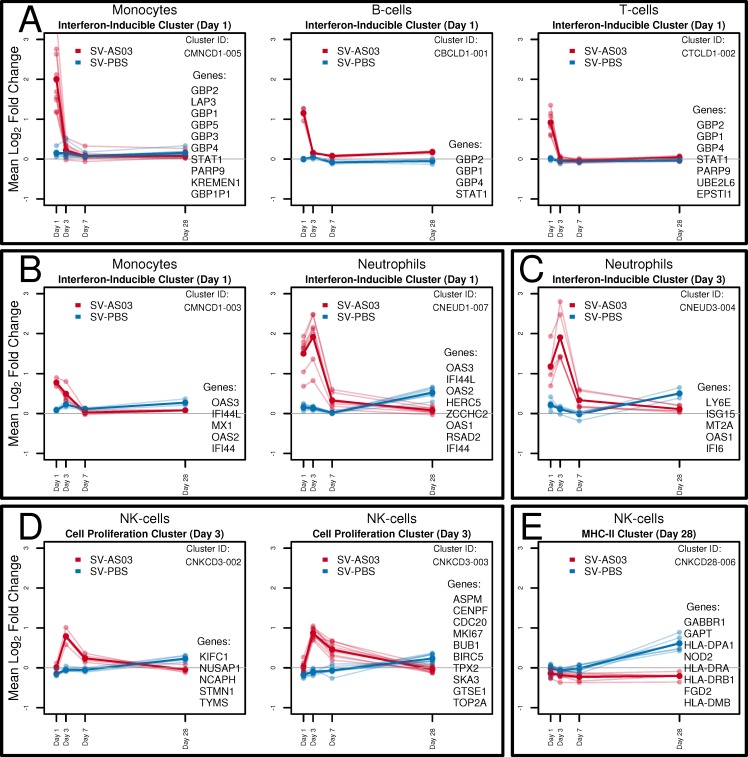
Response time trends of clusters of co-expressed differential genes by vaccine group.Co-expressed gene cluster time trends of baseline log2 fold change in LCPM of DE genes by vaccine group. Header indicates cell type, primary functional classification, and time point. Mean log2 fold change across cluster genes is drawn in bold. Individual mean gene log2 fold changes are plotted in lighter colors. Multiscale bootstrapping was used to determine co-expressed gene clusters. (A) Interferon-inducible clusters with increased responses for the AS03-SV group identified in monocytes, B cells and T cells at day 1. (B) Interferon-inducible clusters with similar gene composition but different responses for the AS03-SV group in monocytes and neutrophils at day 1. (C) Additional interferon-inducible cluster modulated by AS03-SV identified in neutrophils at day 3. (D) Cell proliferation-related clusters with increased responses for the AS03-SV group identified in NK cells at day 3. (E) MHC class-II-related cluster with increased responses for the PBS-SV group identified in NK cells at day 28.